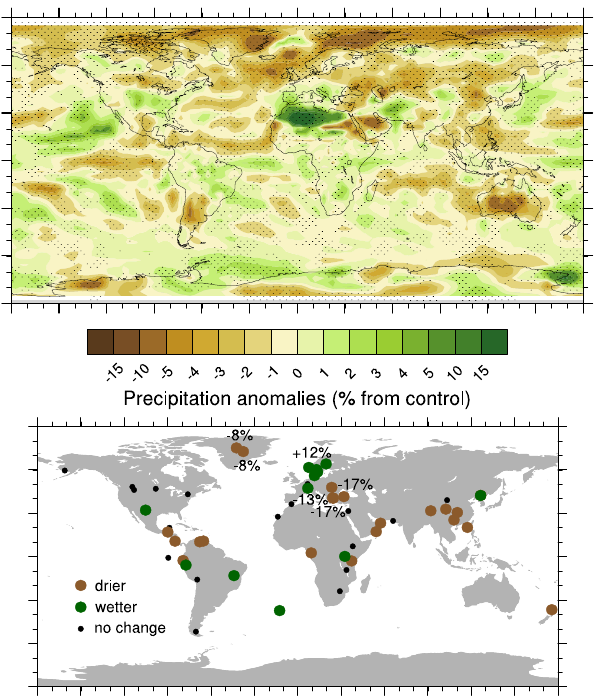
Fig. 10. (Top) Multi-model ensemble mean anomalies of annual- mean precipitation in the first fifty years following the MWP rela- tive to the control simulations, in % change from control. Stippling shows grid cells where at least three of the simulations agree on the sign of the precipitation anomaly. (Bottom) Qualitative and quanti- tative annual-mean precipitation anomalies, in % change from early Holocene background climate, inferred from proxy records for the 8.2ka event, as summarized by Morrill et al. (2013).